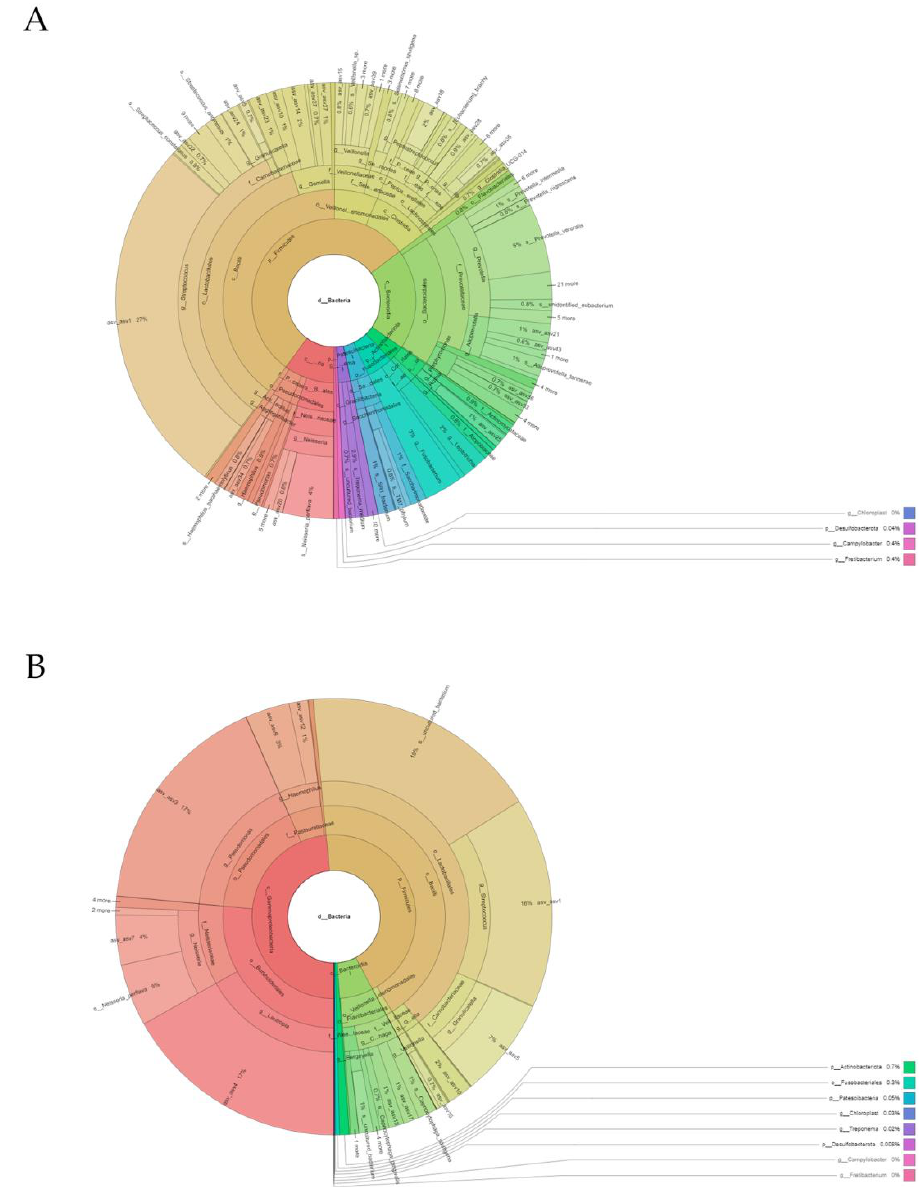
Figure 5. Representation created using the Krona hierarchical browser of the phylotypes identified at the phylum, class, order, family, genus, and species level in an individual with periodontitis: ( A ) Baseline saliva sample; ( B ) Saliva sample after antibiotic